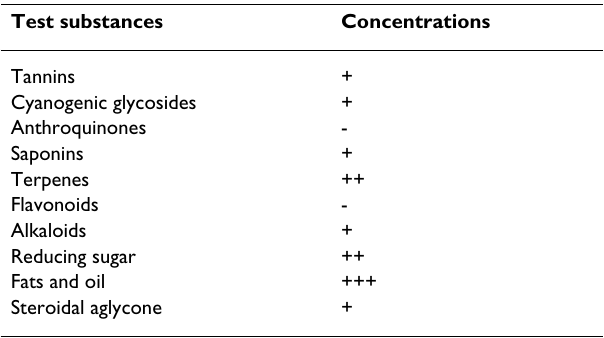
Table 1: Results of the phytochemical analysis of Ocimium gratissimum leaf